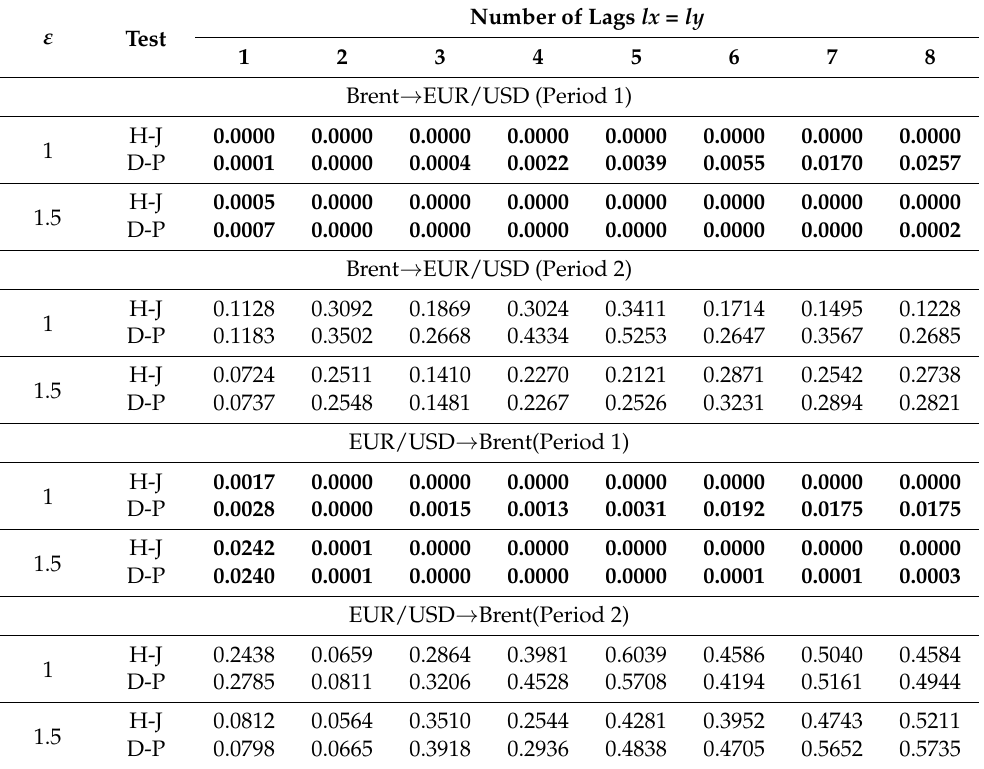
Table 2. Results of nonlinear Granger causality testing for crude oil and EUR/USD.